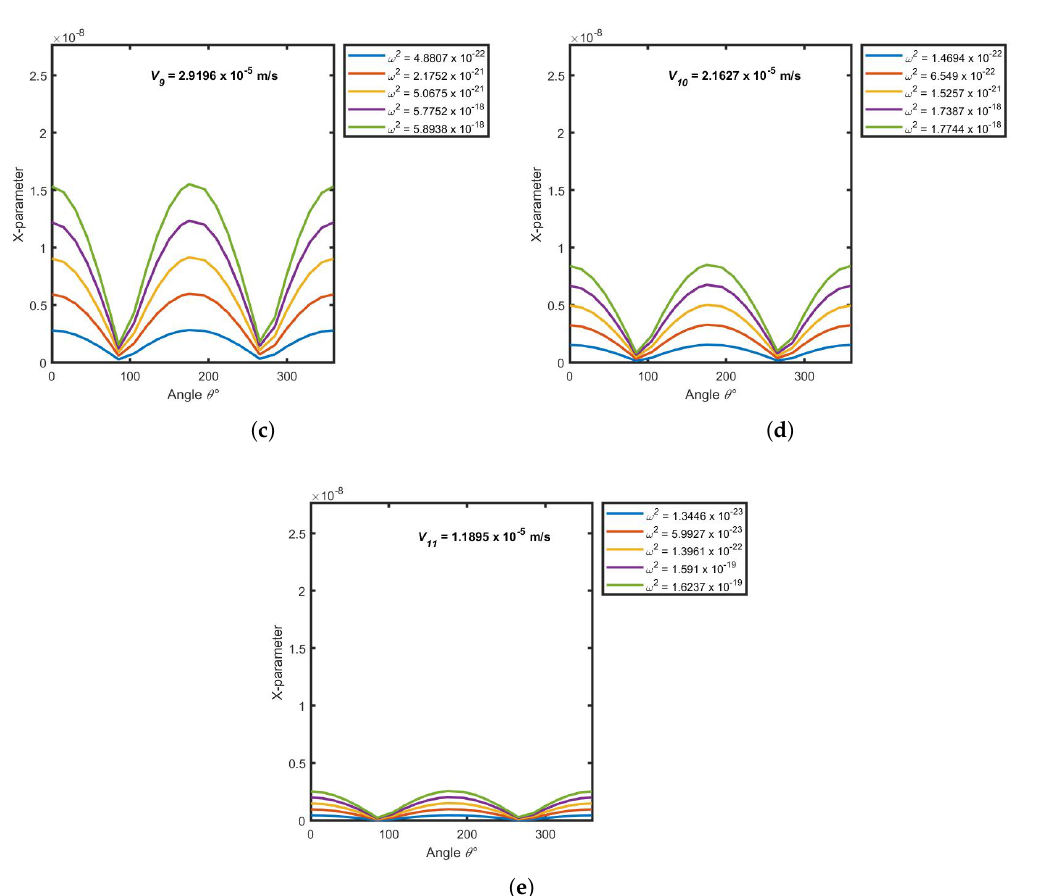
Figure A1. X -parameter ( X p ) as a function of angle ( θ ) for channel thickness h = 1.7 × 10 − 5 m, time t = 10 d and varying separation constant ( ω 2 ) . These results correspond to the second half-wing of those presented in Figure 5. ( a ) v 7 = 3.7846 × 10 − 5 m/s, ( b ) v 8 = 3.4602 × 10 − 5 m/s ( c ) v 9 = 2.9196 × 10 − 5 m/s ( d ) v 10 = 2.1627 × 10 − 5 m/s and ( e ) v 11 = 1.1895 × 10 − 5 m/s.